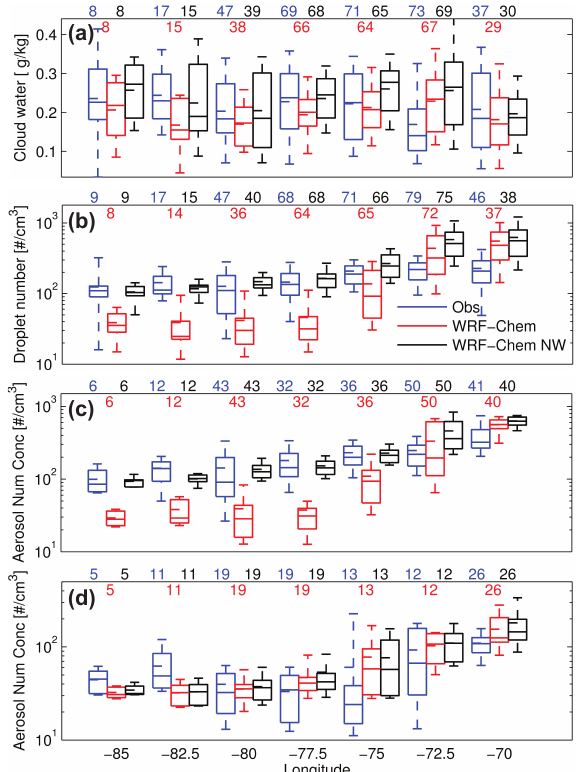
Fig. 5. Box and whisker plots for selected cloud properties and aerosol number concentration as in Fig. 1. (a) Profile mean cloud water content. (b) Profile mean number of droplets concentration. (c) and (d) : marine boundary layer (MBL) and free troposphere (FT) mean profile aerosol number concentration. Number of pro- files is indicated at the top of each longitude bin.